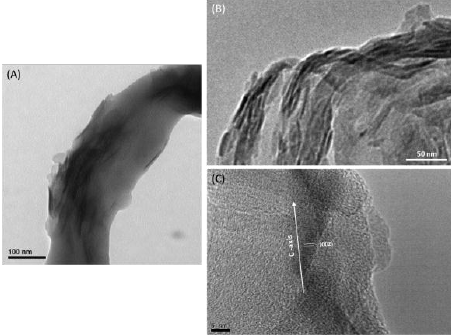
Figure 3. TEM images of mineralized nHap/Col composite material. ( A ) The c-axis of needle-like shape of Hap nanocrystals was specifically oriented along the longitudinal direction of the collagen fibrils; ( B ) each bundle consisting of Hap nanocrystals surrounded with Col fibrils; and ( C ) high-resolution TEM image with interplanar spacing corresponding to the (002) of Hap. Scale bar: ( A ) 100 nm; ( B ) 50 nm; and ( C ) 5 nm.